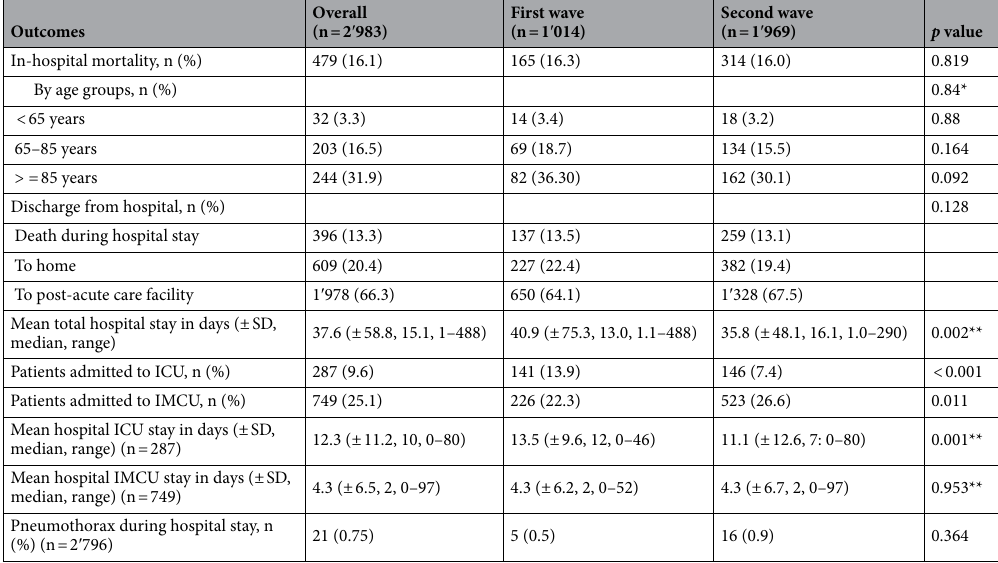
Table 3. Patient Outcomes during the two successive waves. * p value for interaction*Mann–Whitney test.